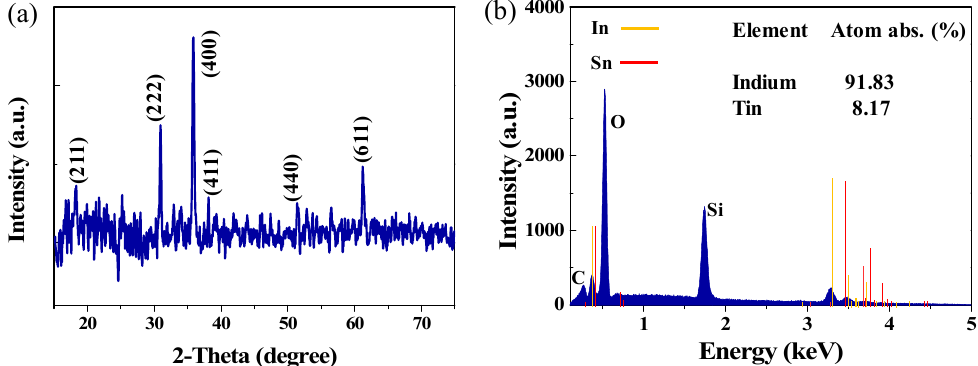
Figure 2. ( a ) The X-Ray diffraction (XRD) image of the ITO film, and ( b ) the energy dispersive spectrometer (EDS) of the ITO film.